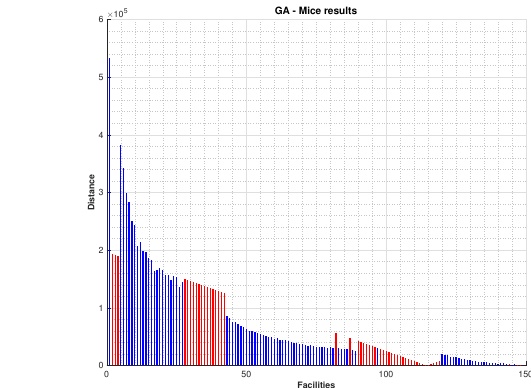
Figure 10. The Pareto set after solving the FLP complemented via KNN for: the Swain dataset ( left ), and the London dataset ( right ).